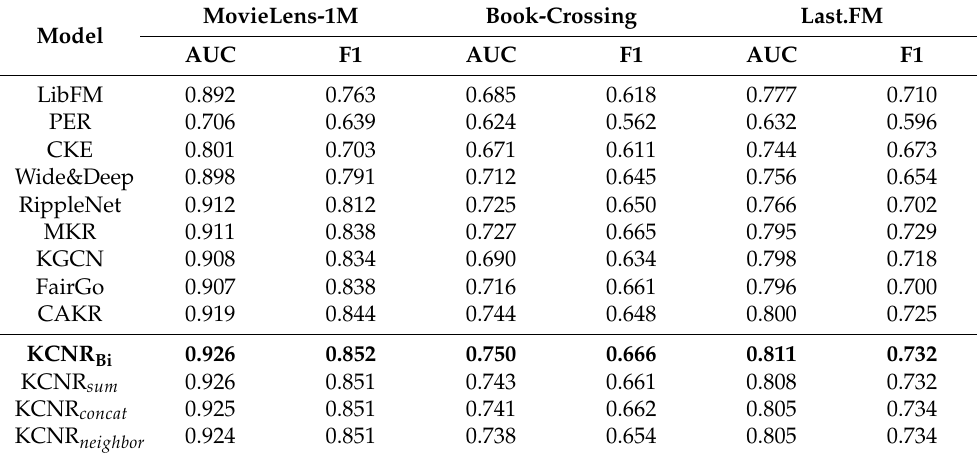
Table 3. The results of AUC and